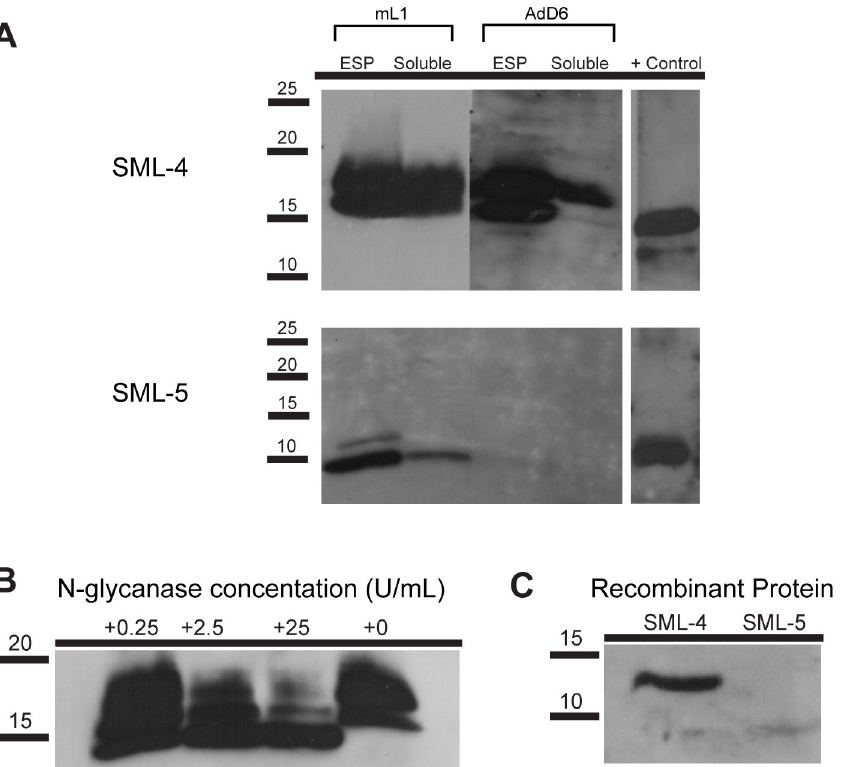
SML-5. (B) T . spiralis ESPs were treated with PNGase F over a range of enzyme concentrations (0.25–25 U/mL) and probed by western blot with antisera to SML-4. (C) Recombinant SML-4 and SML-5 proteins were probed by western blot with pooled BALB/c murine infection sera. Infection sera shows strong reactivity for SML-4 and weaker reactivity for SML-5. Molecular mass markers are shown in